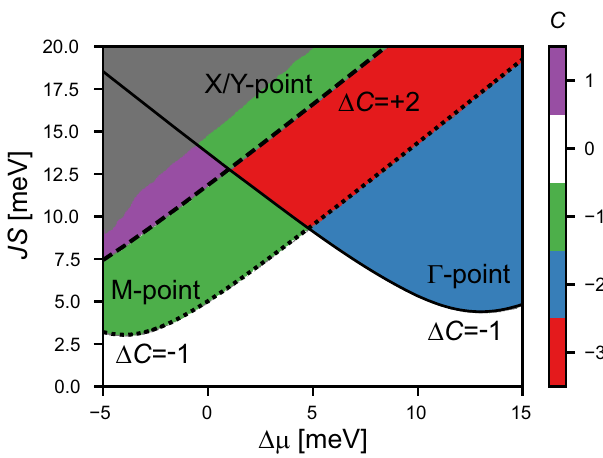
Fig. 1 Topological phase diagram. Topological phase diagram of FeSe 0.45 Te 0.55 in the ( Δ μ , JS )-plane with α = 7 meV. Here, α is the Rashba spin – orbit coupling, and JS is the magnetic exchange strength. Δ μ a is a shift in the chemical potential of orbital a from the value used in Eq. 1), i.e., μ → μ + Δ μ Δ μ = Δ μ for all orbitals a . The solid, dashed, and a a a . Here, a dotted black lines indicate gap closings at the Γ -, X / Y -, and M -points, respectively, which accompany the topological phase transitions. Δ C is the change in the Chern number across a topological phase transition. The gray area denotes the gapless